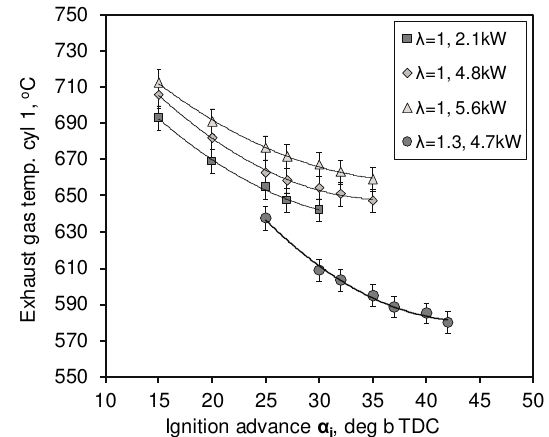
Fig. 10. Exhaust gas temperature measured on cylinder 1 outlet vs ignition timing, throttle position and mixture